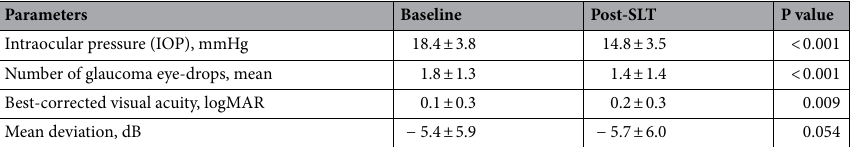
Table 2. Intraocular pressure, glaucoma medication, best corrected visual acuity and mean deviation before and after SLT. SLT selective laser trabeculoplasty, dB decibels.